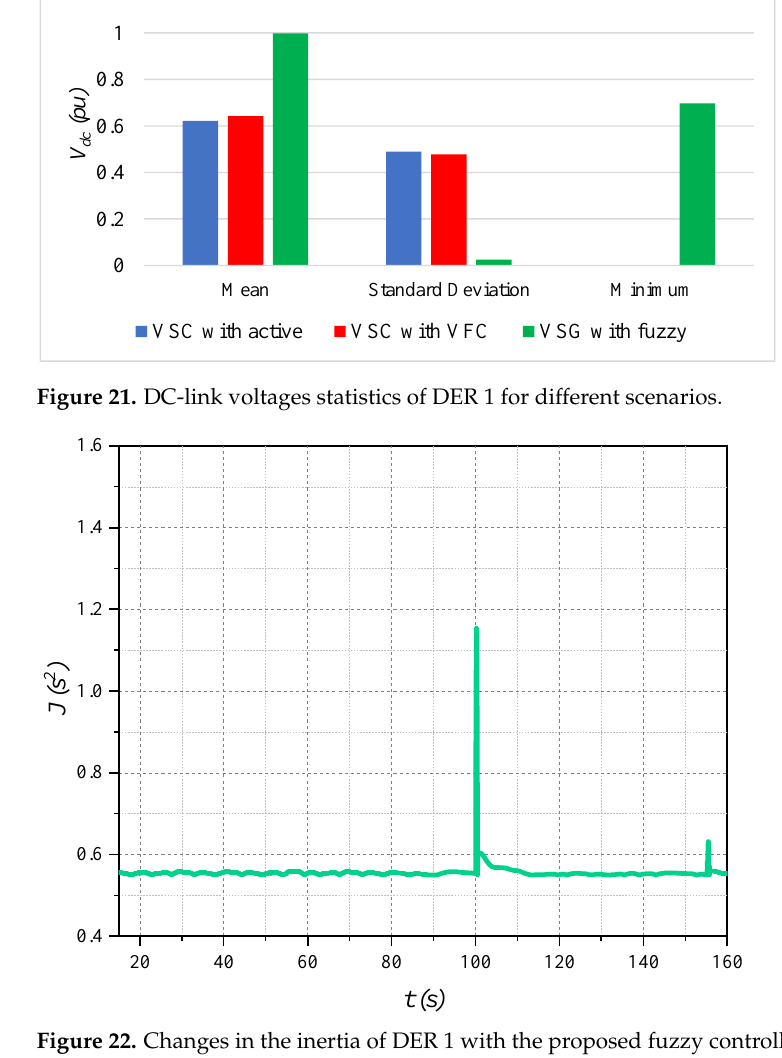
Figure 22. Changes in the inertia of DER 1 with the proposed fuzzy